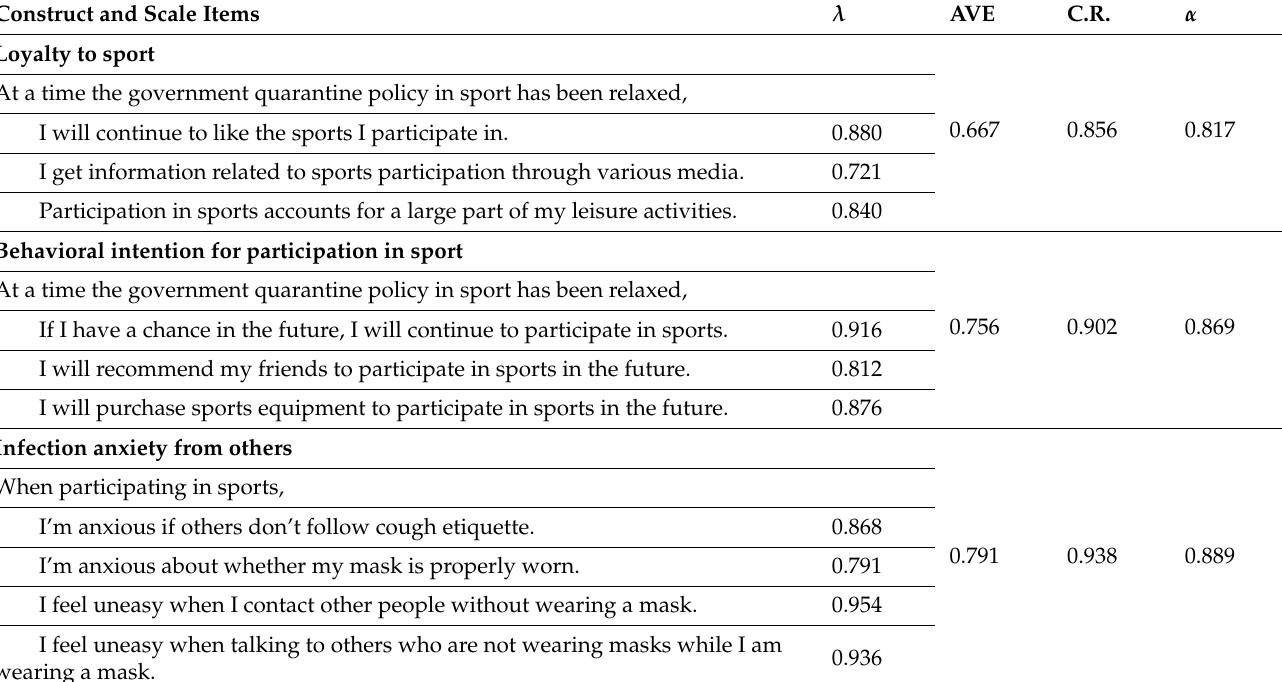
Table 2. Confirmatory factor analysis and reliability